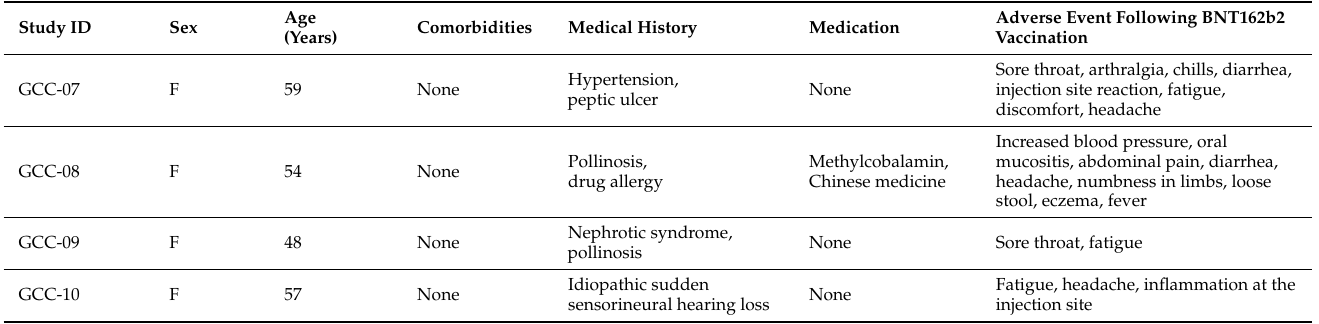
Table 1. Characteristics of the four healthcare workers who experienced acute allergic-like reactions to the first dose of BNTb2